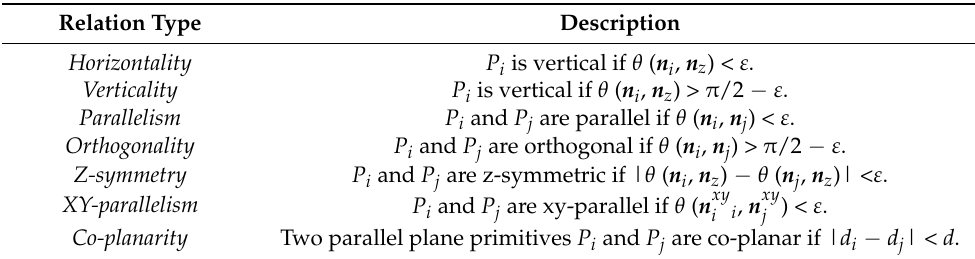
Table 1. Geometric relations used to refine the planar primitives of